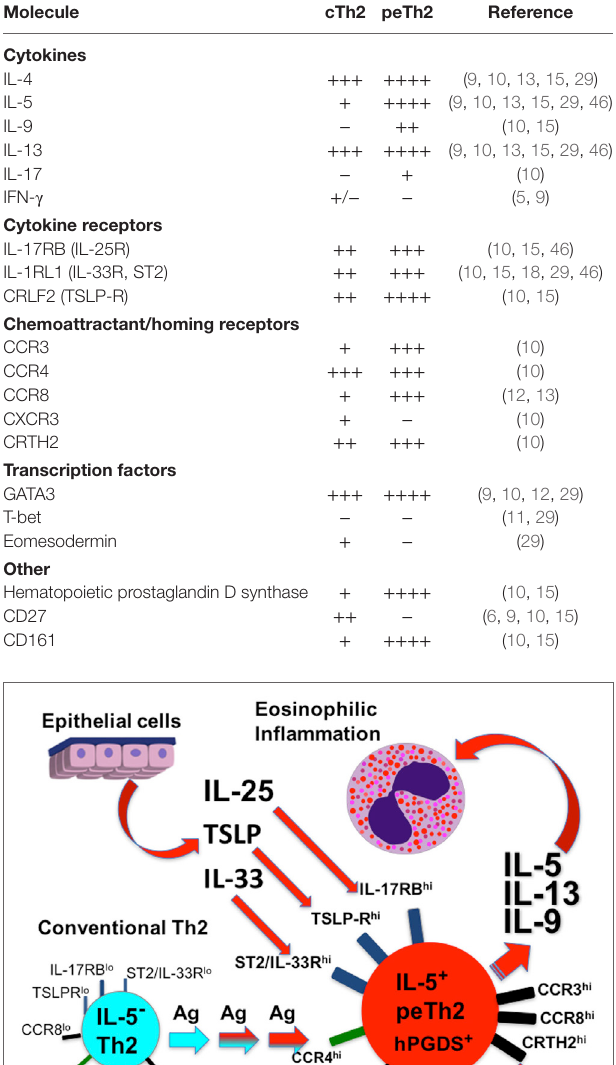
TABLe 1 | Molecular features of pathogenic effector Th2 (peTh2) vs. conventional Th2 (cTh2).